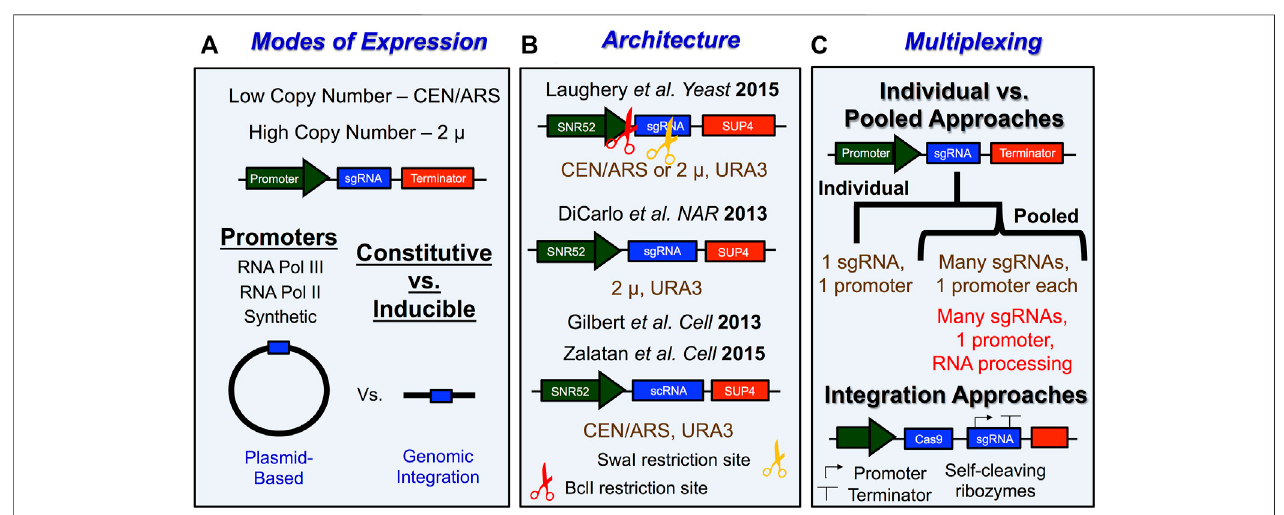
FIGURE 4 | Tips and tricks for expressing sgRNA in S. cerevisiae. (A) Schematic with overview of important experimental considerations for how sgRNA is expressed in yeast. sgRNA is typically expressed from vectors with low-copy number origins of replication like CEN/ARS or from high copy number origins of replication like 2 µ. Promoters for sgRNA expression typically involve either constitutive or inducible expression of individual or multiple sgRNAs from either a RNA Pol III promoter, RNA Pol II promoter, or a synthetic promoter. Lastly, sgRNAs that get expressed in yeast cells are typically transcribed from plasmid-based vectors or from elements that were directly integrated into the yeast genome. (B) Examples of sgRNA expression vector architecture. URA3 is a commonly used selection marker for sgRNA expression vectors and can be used to select for transformants as well as to remove sgRNA expression machinery from yeast cells. LEU2 markers have also beenused.BclI(3 ’ ofpromoter)andSwaI(inthesgRNA)restrictionsitesareusedforsimplifyingconstructionofnewtargetingsgRNAsinsgRNAvectors.Thisisdoneby digestingtheplasmid, then hybridizingauser-de fi ned 20 ntDNAsegmentwitha5 ’ GATC overhangtofacilitatethesubsequentligationofthiscassetteintotheplasmid. (C) Schematic describing general approach for multiplexing CRISPR/Cas9 genome editing experiments in yeast. One key consideration is whether a plasmid-based or integration approach is going to be utilized. Plasmid-based approaches will typically involve pooled systems in which many different sgRNAs are expressed from separate promoters within the same construct or the different sgRNAs are generated upon independent processing by ribozymes or other RNA processing enzymes. Strategies employing gRNAs that are fl anked by cleavage RNA sequences make use of self-cleavable ribozyme sequences ( e.g ., Hammerhead ribozyme and HDV ribozyme), exogenous cleavage factor recognition sequences ( e.g ., Cys4), and endogenous RNA processing sequences ( e.g ., tRNA sequences and introns). For more details see Stovicek et al., 2017; Lian et al., 2018; Raschmanová et al., 2018; Ding et al., 2020; Malc ı et al., 2020; Utomo et al., 2021; Zhang et al., 2021.